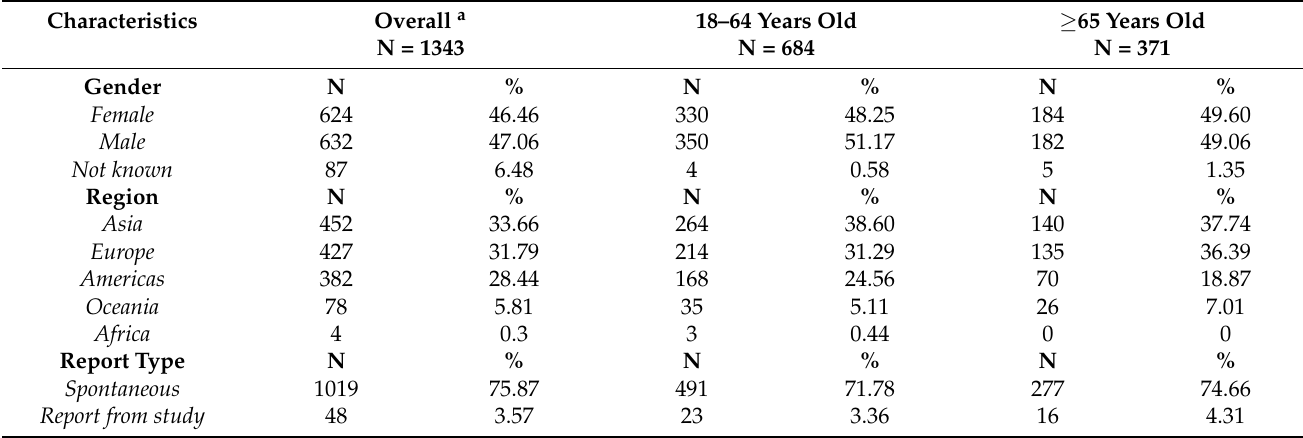
Table 1. Characteristics of the individual case safety reports, overall and by age categories.